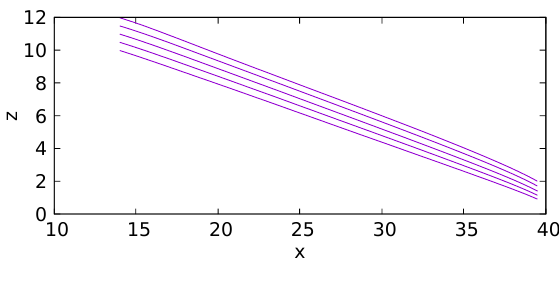
Figure 3. Plot of streamlines for mass flow rate of 88.3 g / s. Qual- itatively similar plots are obtained for the other flow